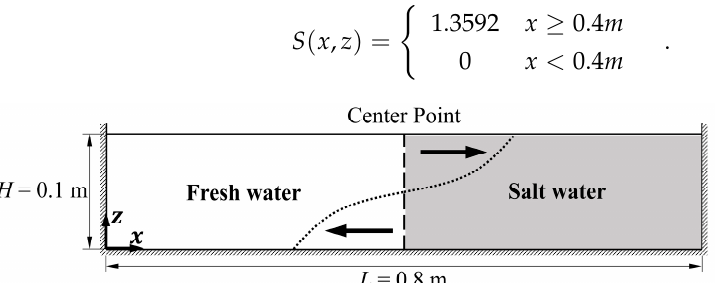
Figure 11. Schematic of lock-exchange domain and the initial condition of simulation. The arrows present the directions of the currents; the black dashed line indicates the gate between light and heavy fluid; the dotted line shows a diagrammatic view of the interface between the two fluids after the release.